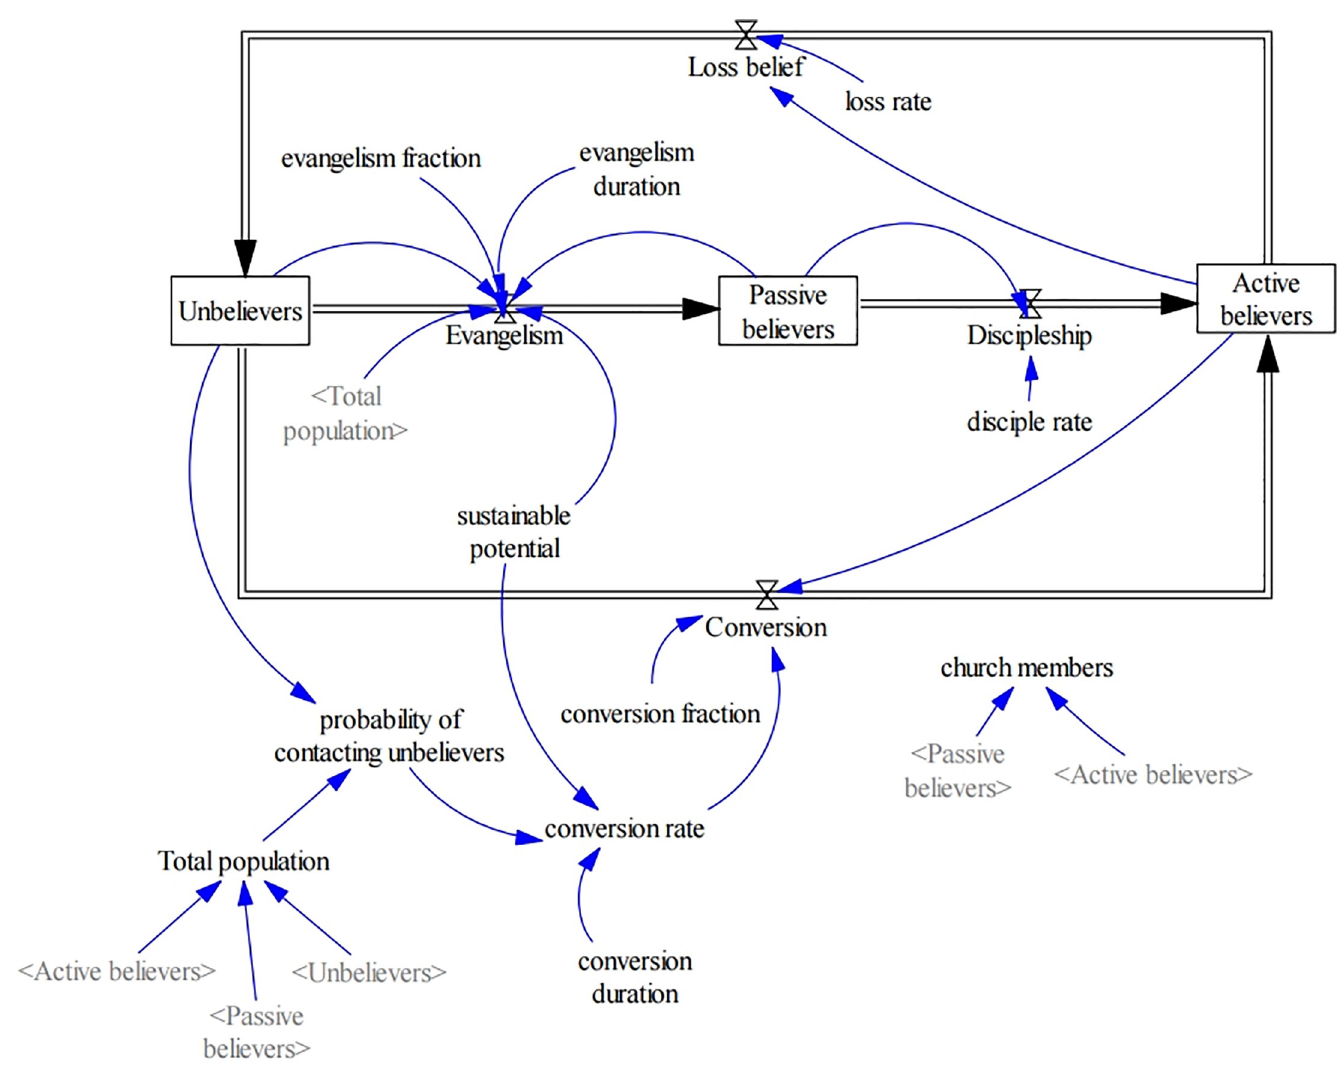
Fig 1. Stock and flow prototype diagram for a church population (S1